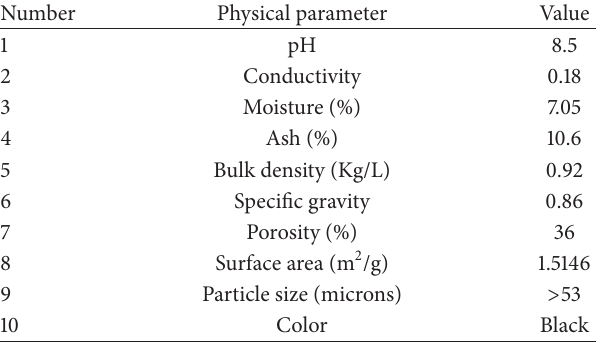
Table 1: Physical parameters of activated Moringa oleifera